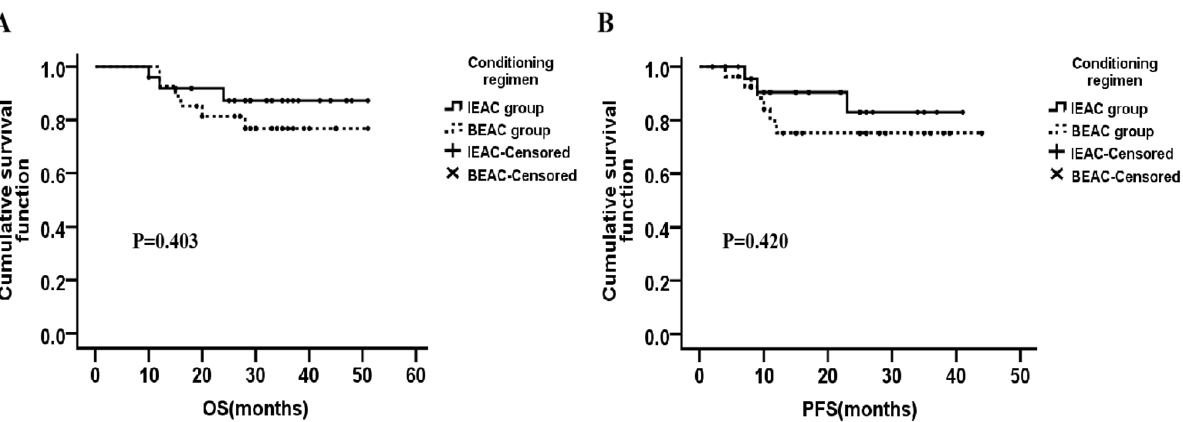
Figure 3. There’s no significant difference in OS and PFS of DLBCL patients between IEAC group and BEAC group.